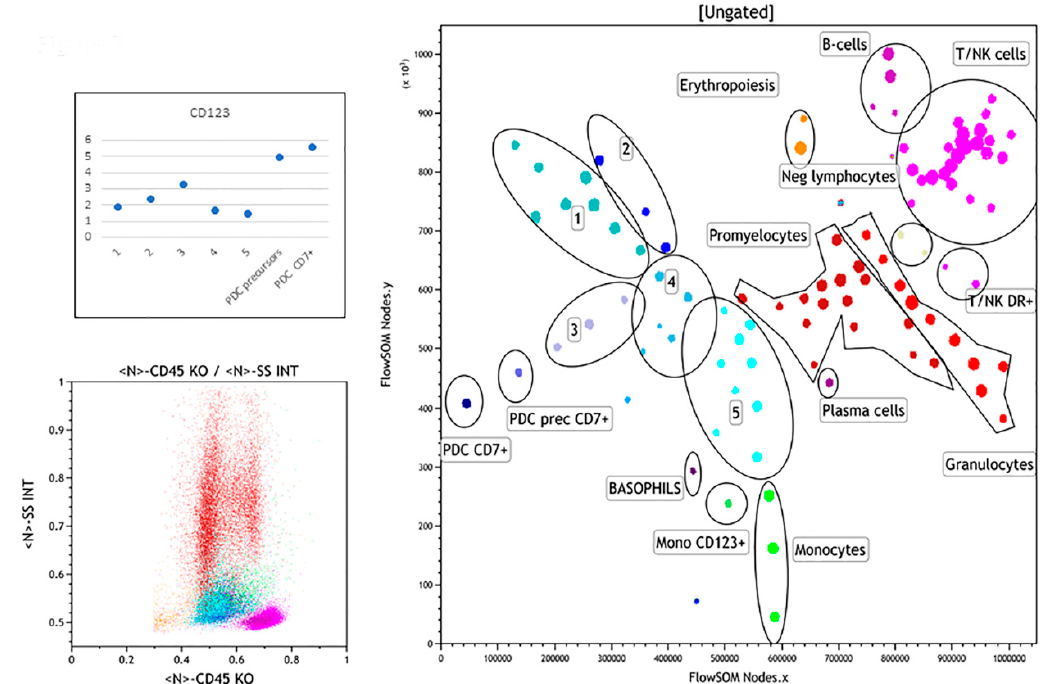
Figure 7. FlowSOM analysis of Case 6. Minimal spanning tree is shown in the right panel. The apparently homogeneous blastic population was objectived by a CD45/SSC scattergram ( bottom left ) is dismembered in 5 progenitor clusters while PDC segregates in two nodes based on CD34 expression (Supplementary Table S9). Normalised MFI of CD123 expression in numbered subsets of progenitors and PDCs are shown in the upper-left diagram.